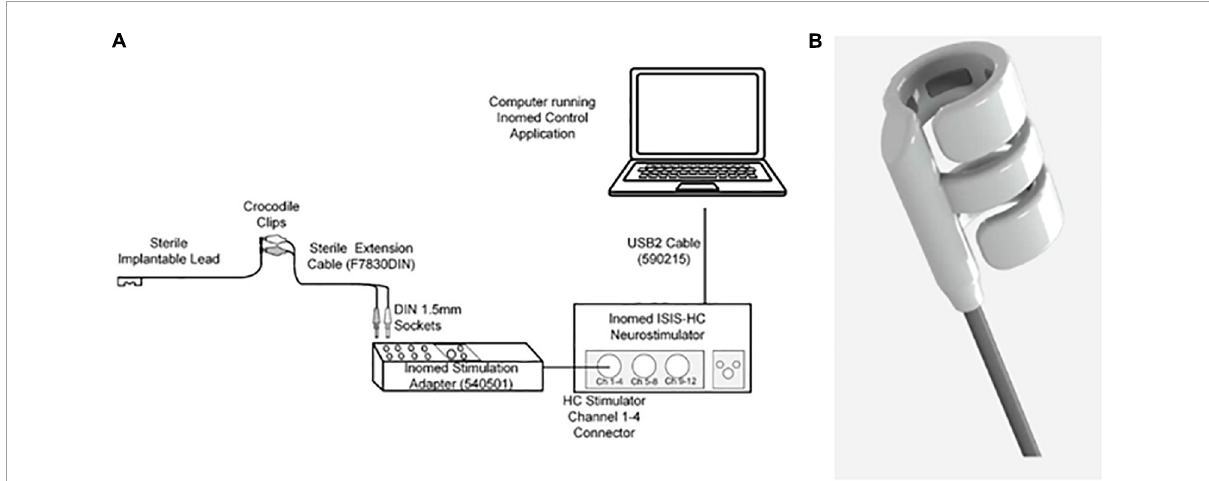
FIGURE1 (A) Stimulation set-up. A laptop with the stimulation software (Inomed Control Application) was connected to the Inomed Neurostimulator (Model 504185). Via the extension cable, the neurostimulator was connected to the sterile implantable cuff. (B) The distal end of the cuff. This is a cuff which was composed of two arms with electrodes and one middle arm, designed to fit around the SpA